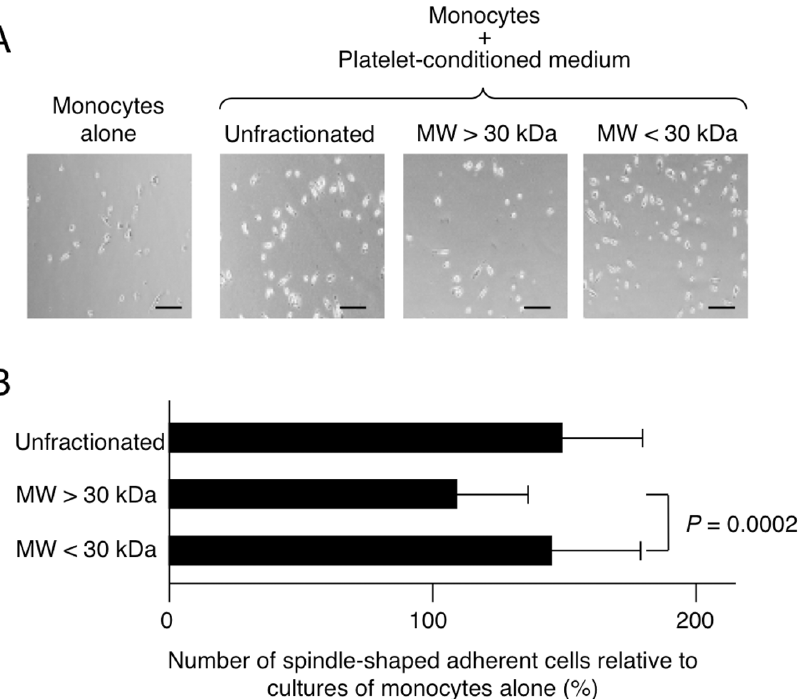
Figure 3. The MOMC generation activity resides in the MW , 30-kDa fraction of platelet-conditioned medium. CD14 + monocytes were cultured on fibronectin with or without unfractionated or fractionated platelet-conditioned medium prepared by stimulating platelets with thrombin. ( A ) Adherent cell morphology on culture day 7. Bars: 200 m m. ( B ) The generation of spindle-shaped adherent cells in the indicated cultures, expressed as a proportion (%) of those generated by culturing monocytes alone. Results show the mean and SD of three independent experiments.